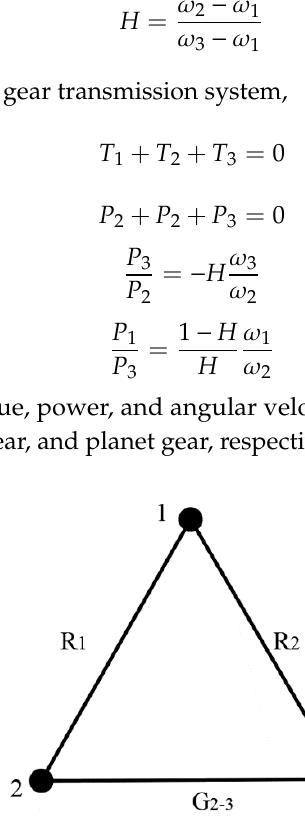
Figure 3. Kinematic relationship between gear 2, gear 3, and carrier 1.